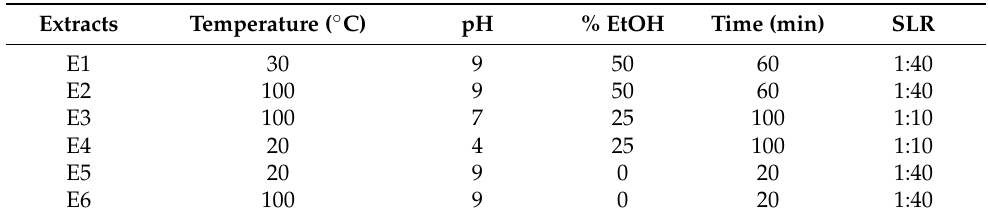
Table 1. Selected extracts and respective extraction conditions: temperature, pH, percentage of ethanol, time and solid–liquid